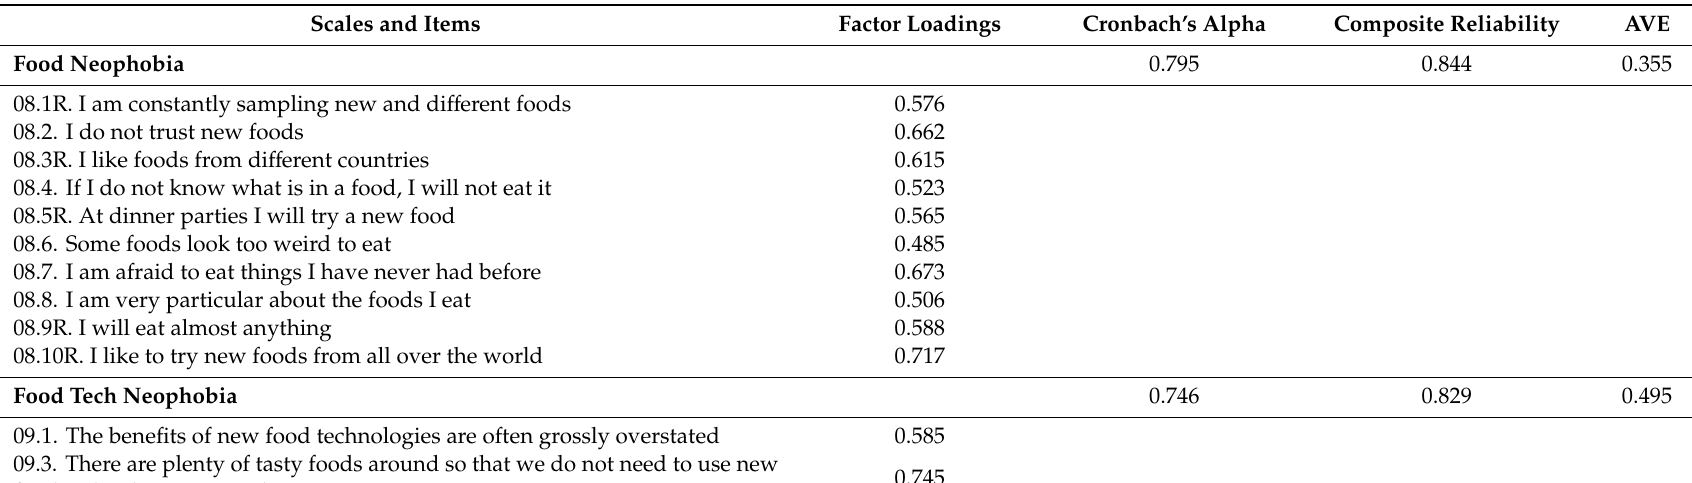
Table 2. Scale Loadings, Reliabilities, and Convergent